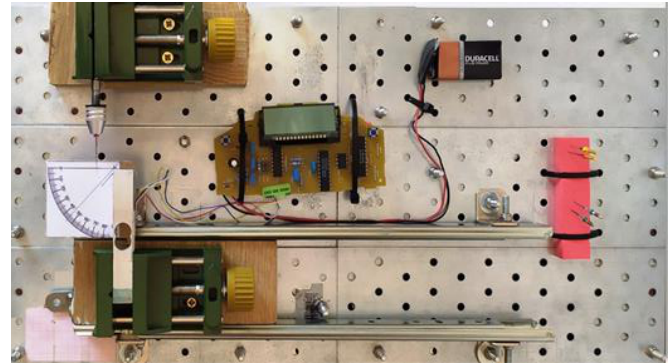
Figure 1. Mobile bending resistance device: overview.